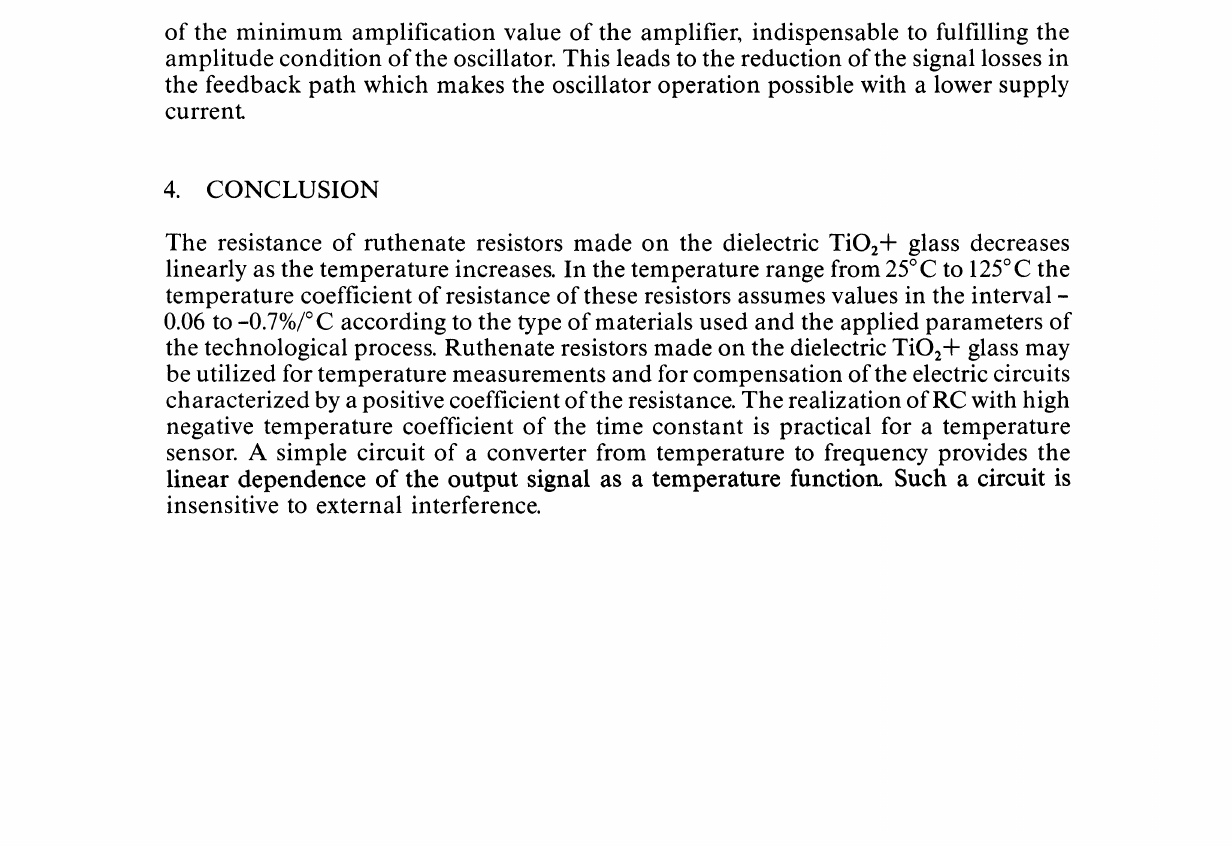
FIGURE 8 Frequency change as function of ambient